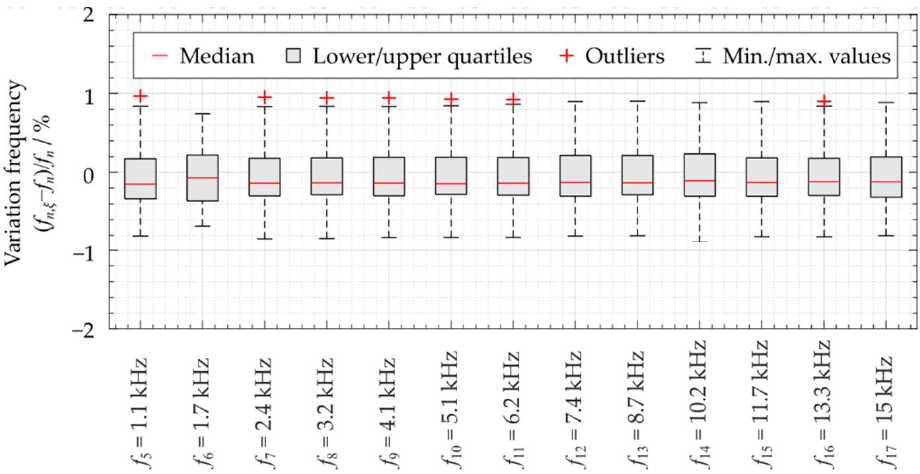
Figure 6. Variation of the measured natural frequencies (bending mode) f j , ξ of the polymeric specimen ξ = 1, 2, . . . , 10 (tightening torque M t = 1.1 Nm, voltage amplitude of the actuator ˆ U e = 11 V).